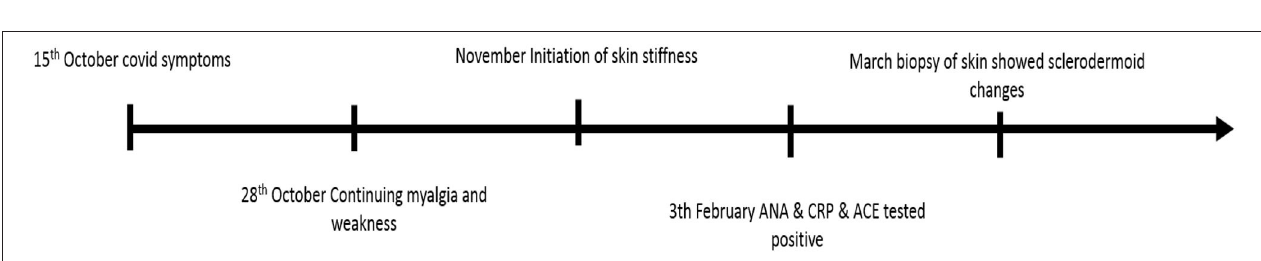
FIGURE 3 | Timeline of